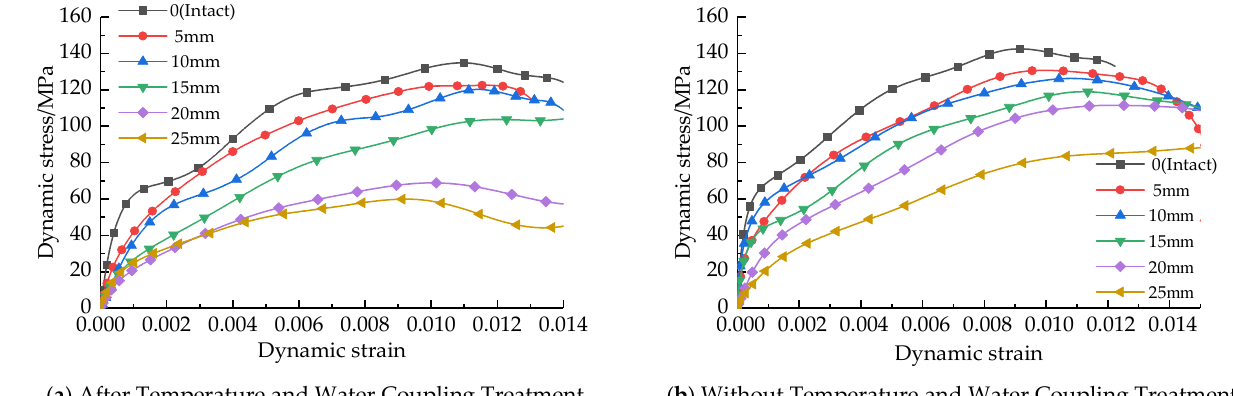
Figure 8. Dynamic stress-strain curve of sandstone specimen.